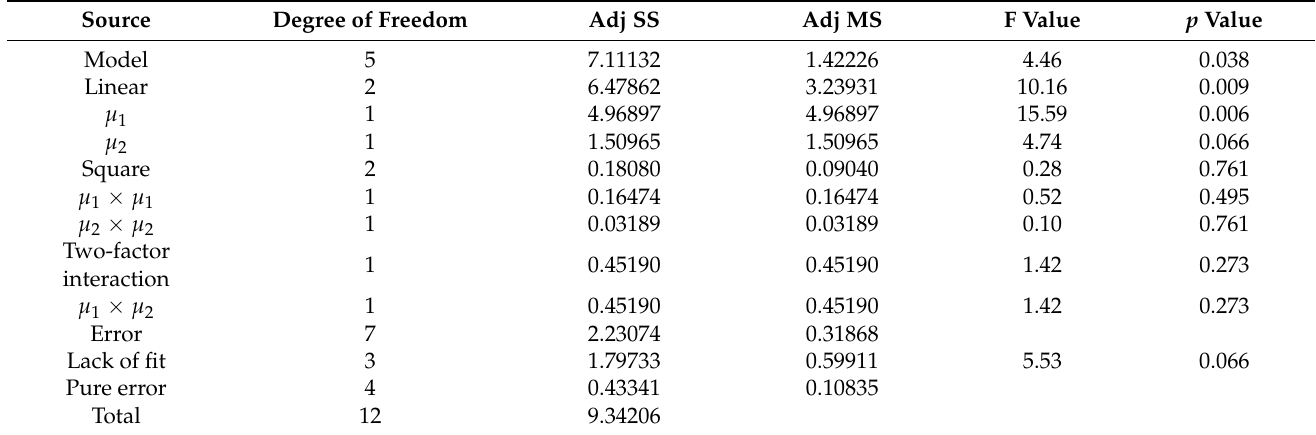
Table 5. Analysis of variance for